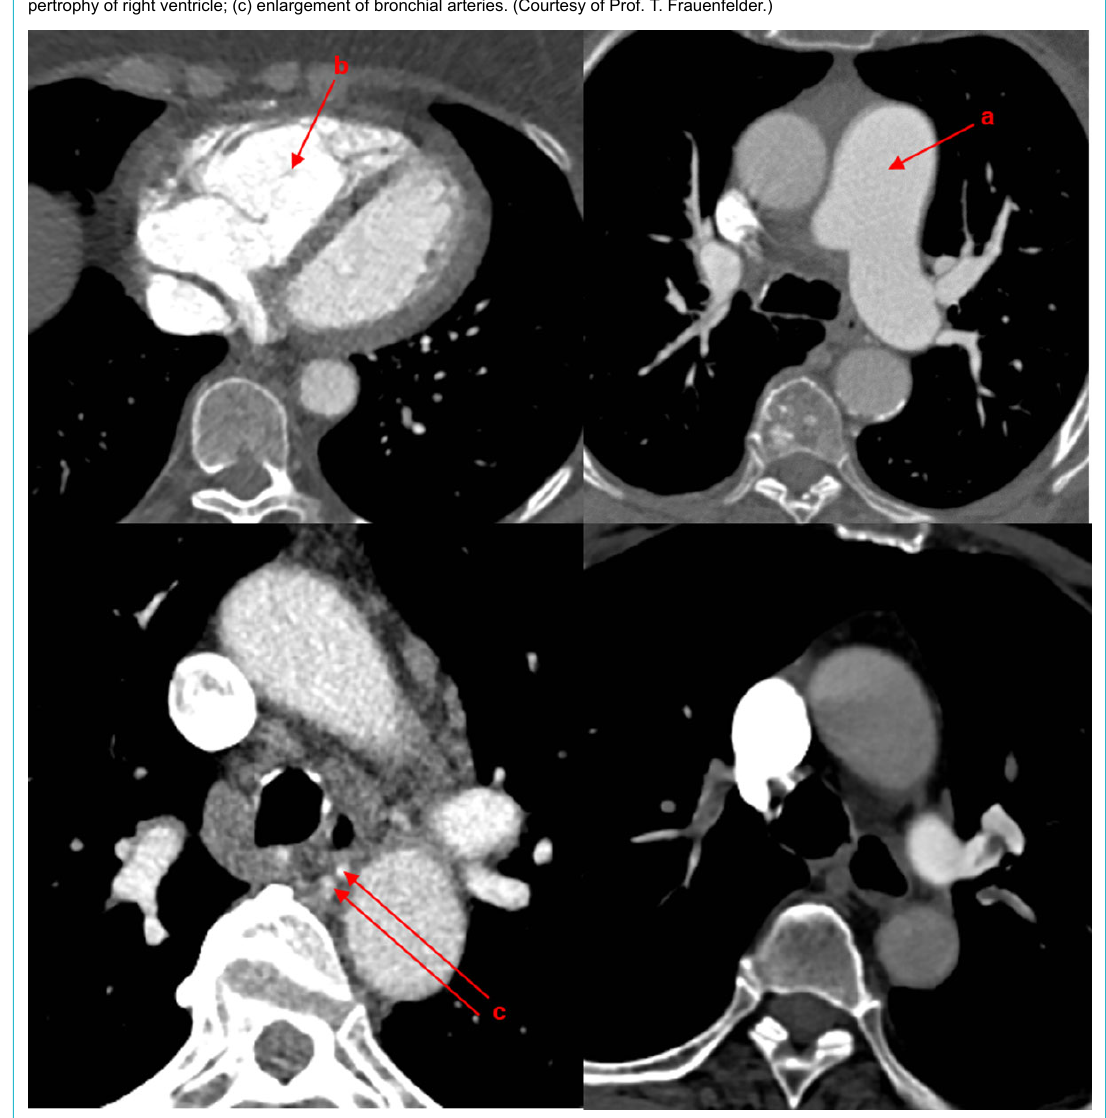
Figure 9: Systemic vascular characteristics on computed tomography. (a) Enlargement of central pulmonary vessels; (b) enlargement and hy- pertrophy of right ventricle; (c) enlargement of bronchial arteries. (Courtesy of Prof. T.